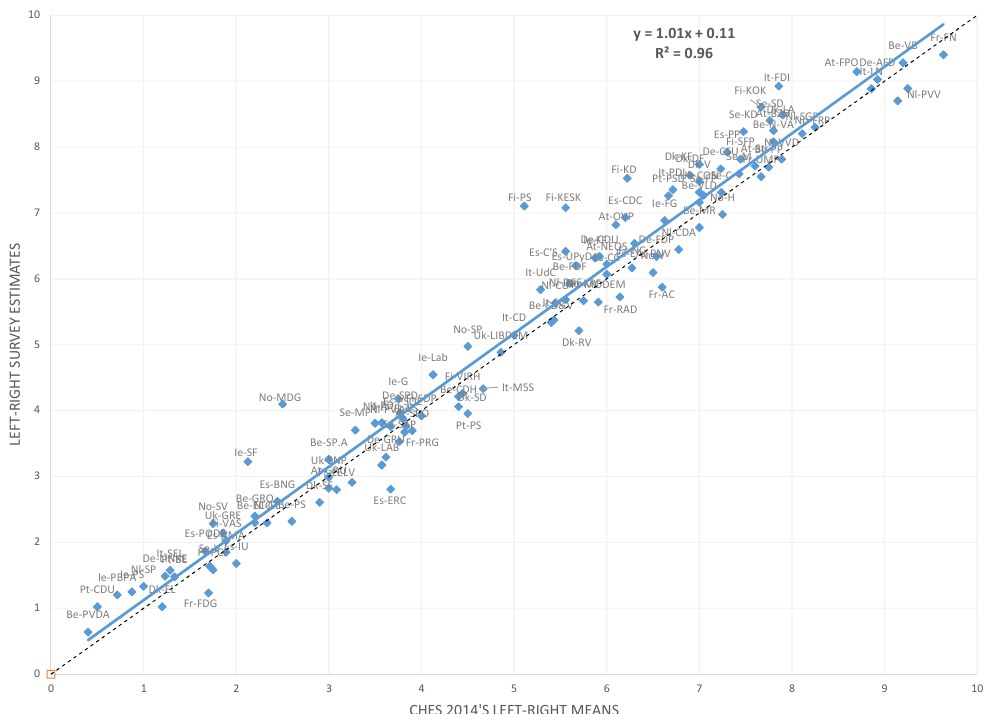
Figure 1. Parties’ left–right estimates versus Chapel Hill Expert Survey (CHES) 2015 mean scores. Each party is identified with a country and party code. The dotted 45-degree line represents the perfect match between the two surveys’ assessments. The solid line is the fitted linear regression line. The two lines overlaps almost perfectly, providing support for the cross-validation hypothesis. Furthermore, the linear relation provides an excellent fit between the two measures (with an R 2 of 0.96). There are a few outliers, mostly among the Finnish parties–the Centre Party of Finland (Fi-KESK), the Finns Party (Fi-PS), and the Christian Democrats (Fi-KD)–with a divergence between the two surveys’ ratings of more than one point on the 11-point scale (1.52, 1.99, and 1.30, respectively). The few remaining outliers include the Irish party Sinn Féin (Ie-SF), the Italian party Brothers of Italy (It-FDI), and the Norwegian Green Party (No-MDG), with a divergence of 1.10, 1.07, and 1.60 points,